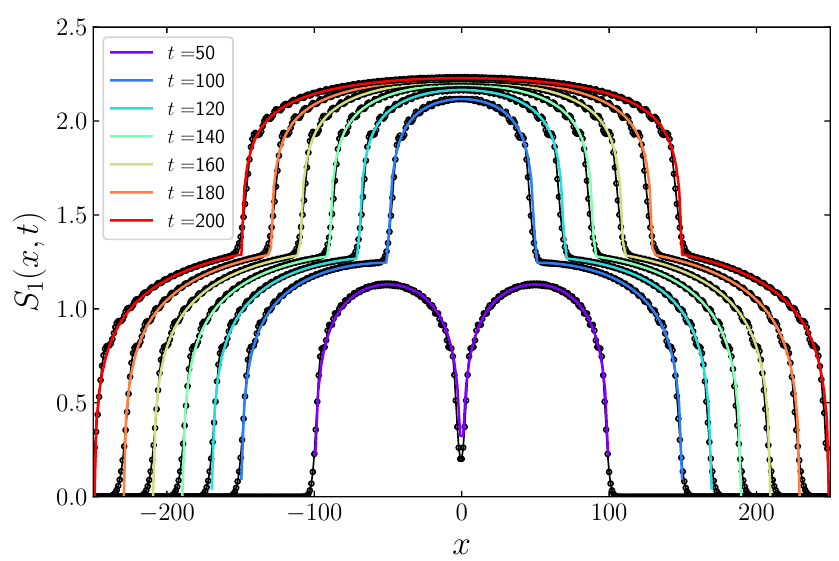
Figure 6: Evolution of the entanglement profiles in the double domain wall melting of a non-interacting spin-1 / 2 chain. The symbols are obtained with exact lattice numerical calculations while the full-line is our result in Eq. (45). The numerical data are obtained for a chain of size L = 600 and setting (cid:96) =